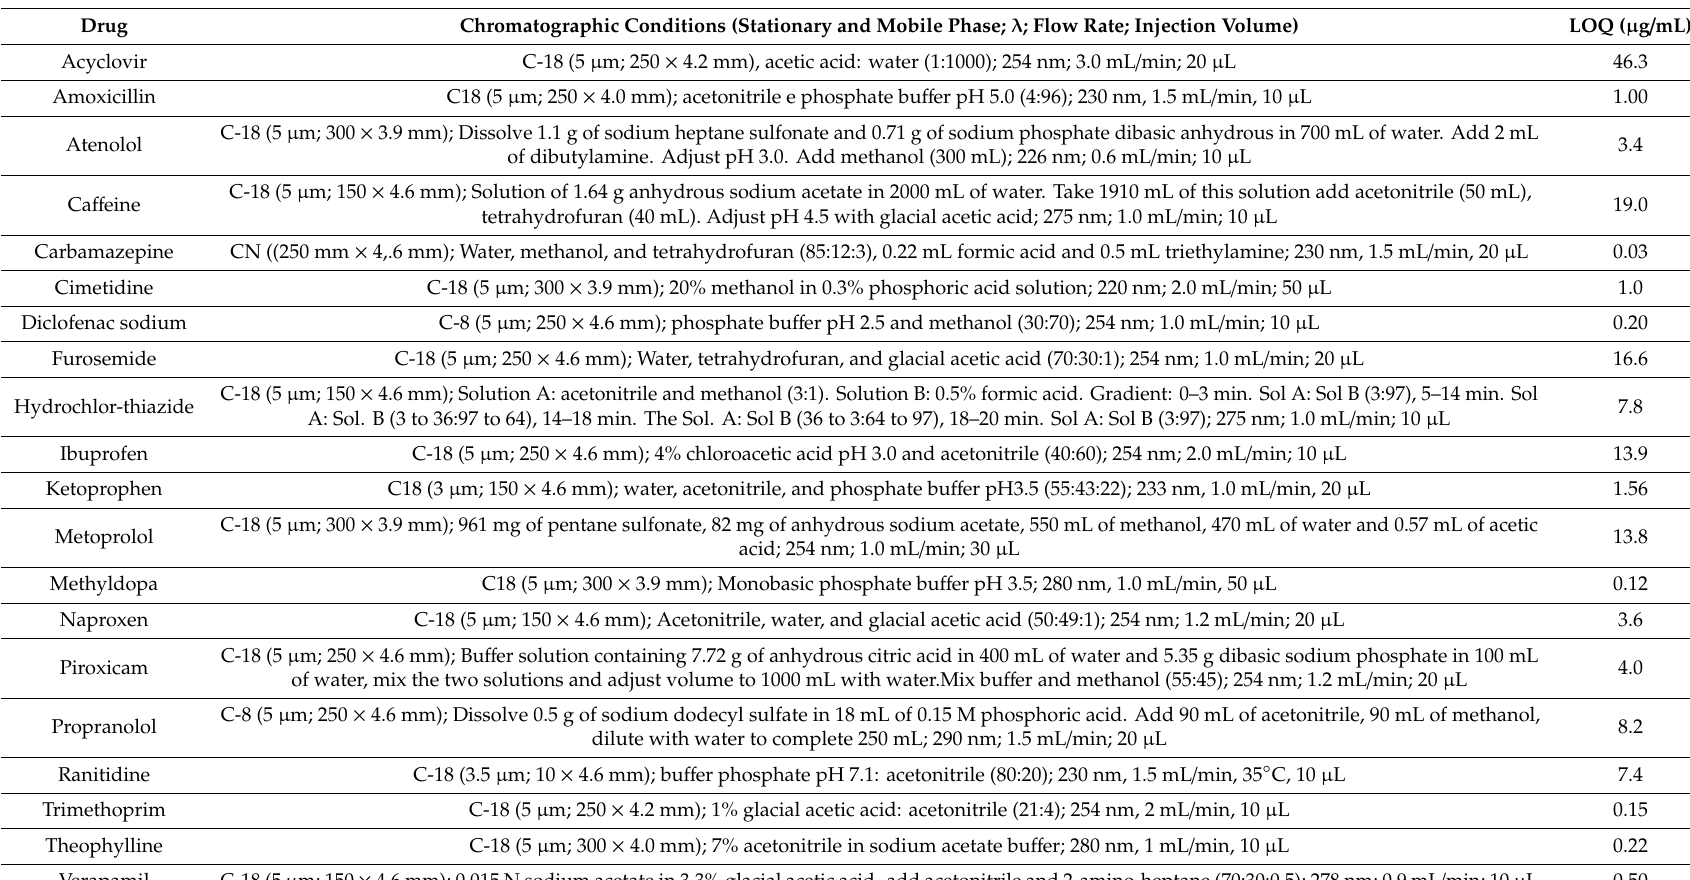
Table 1. Pharmacopeial methods applied on drug analysis and their respective limit of quantification